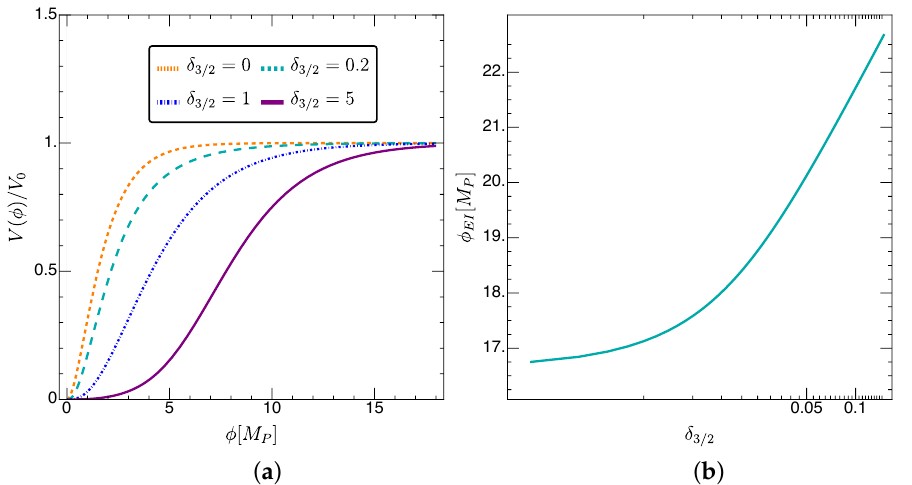
Figure 1. ( a ) The R 3/2 model effective potential for various δ . ( b ) Plot of the minimal initial value φ EI , above which the inflation becomes eternal as a function of the coupling